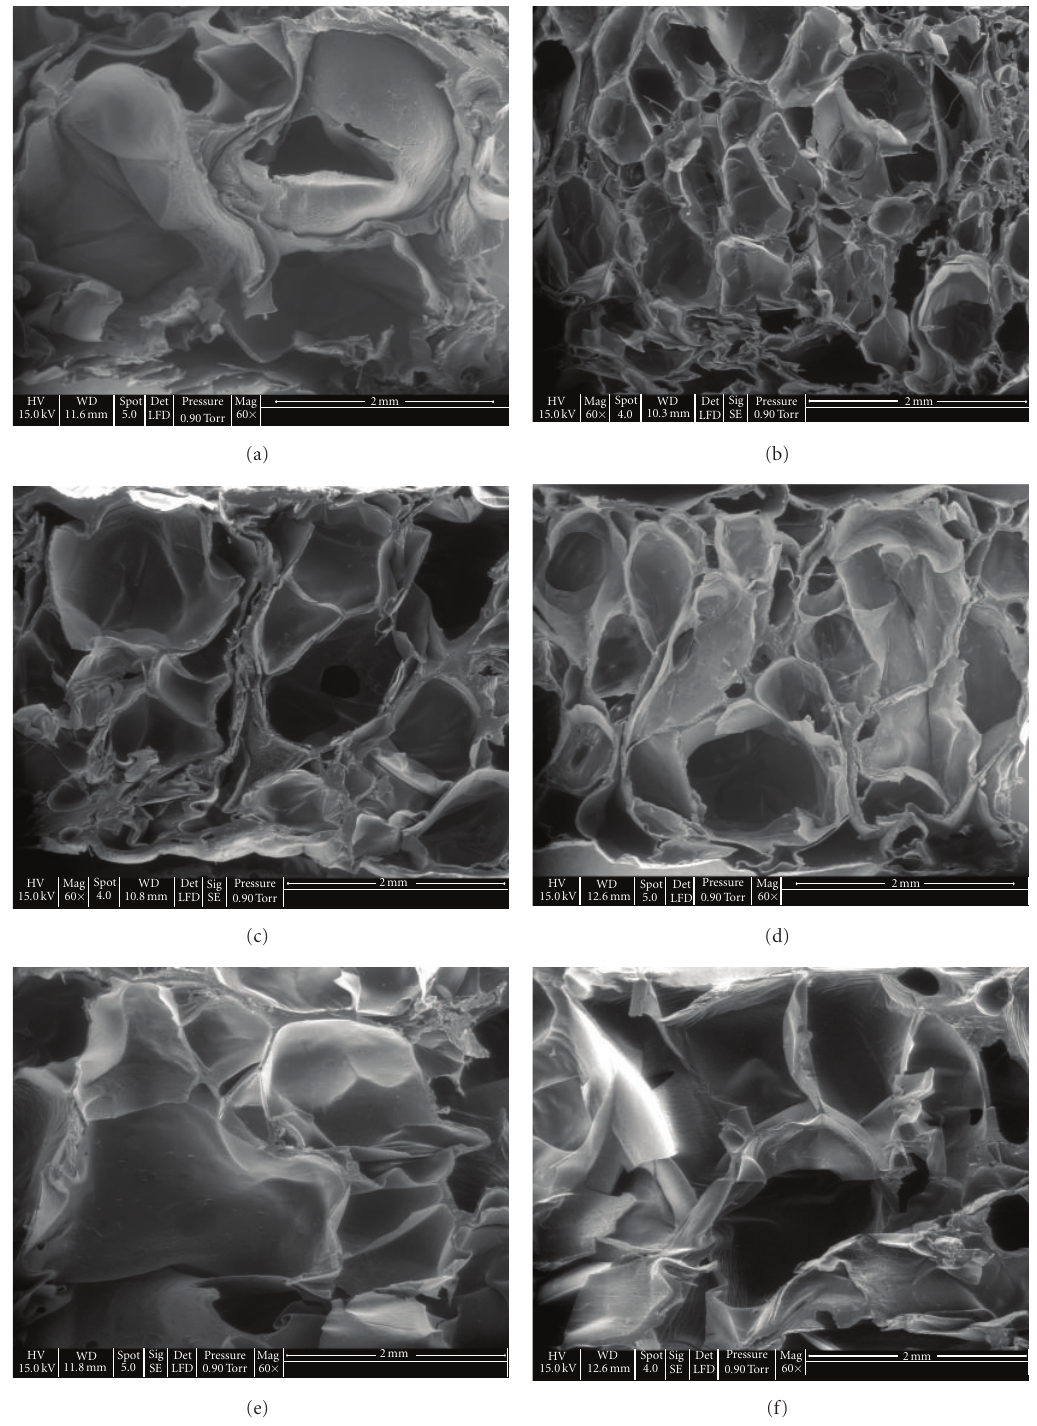
Figure 1: Cell morphology (a) starch foam; biocomposites foams reinforced by 10 wt% of (b) cotton linter (c) hemp and (d) cellulose fibres and 7wt% of (e) sugarcane (f) coconut